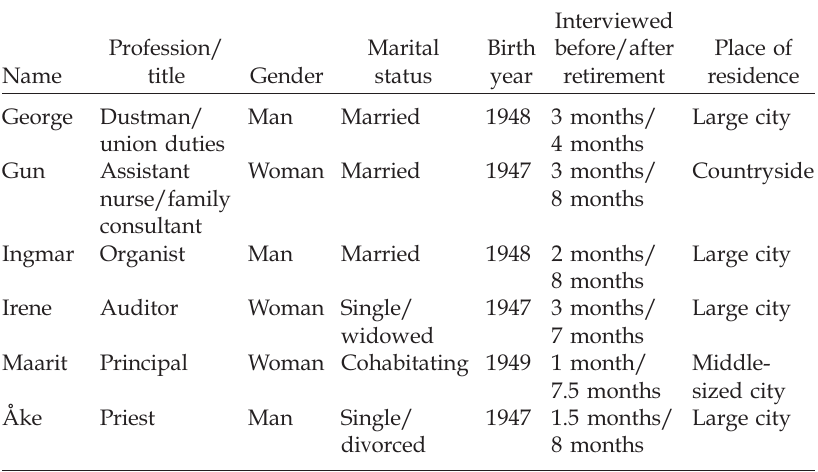
Table 1. Selection of inter v iewees according to assigned name, profession/ title, gender, marital status, birth year, time of interview before/after retirement, and place of